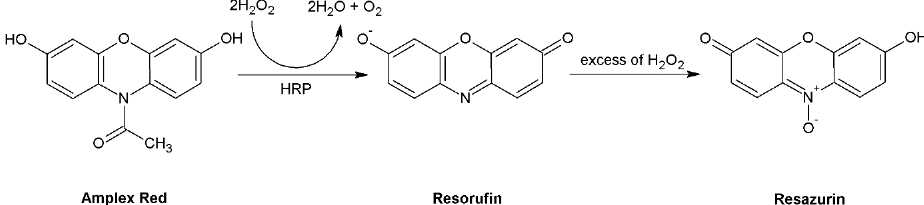
Figure 5. Oxidation of Amplex Red to a fluorescent (resorufin) and non-fluorescent (resazurin) product. Abbreviation: HRP = horseradish peroxidase.